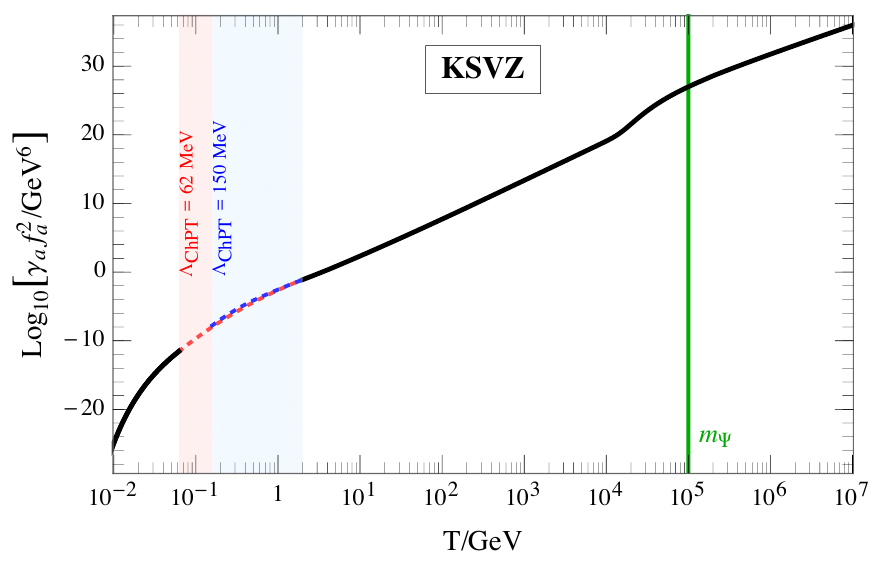
Figure 4 . KSVZ axion production rate for a heavy colored PQ fermion mass m Ψ = 10 5 GeV